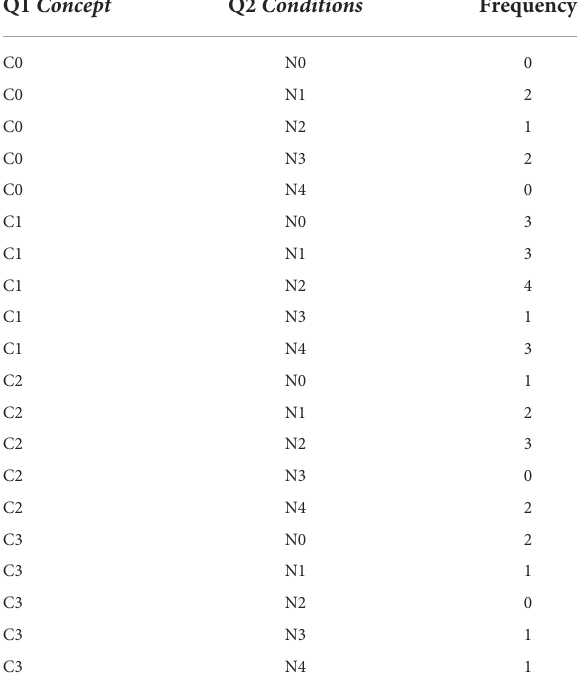
TABLE 10 Frequency table of respondent Q-sort pairings. Q1